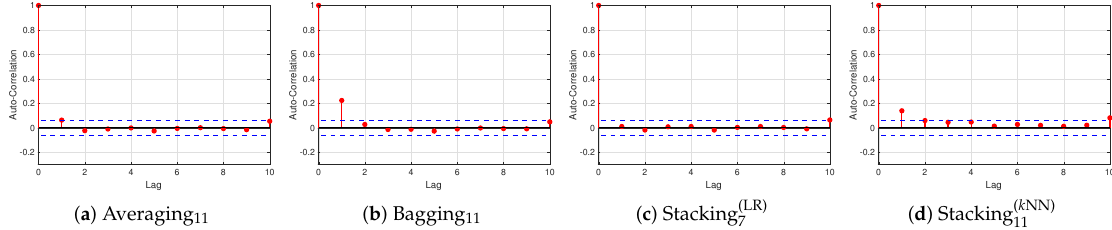
Figure 6. Auto-correlation of residuals for XRP dataset of ensemble models using CNN-LSTM as base learner. Figures 7–9 present the ACF plots of averaging 11 , bagging 11 , stacking (LR) ensembles utilizing CNN-BiLSTM as base learner for BTC, ETH and XRP datasets, respectively.